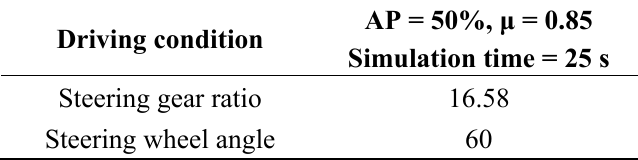
Table 6. Simulation conditions in a cornering